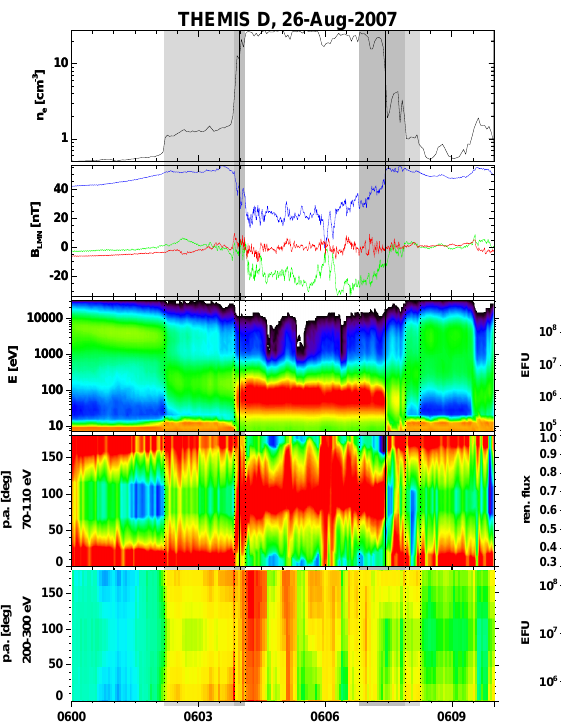
Fig. 7. Event 1. The electron density; the magnetic field in the LMN coordinate system (L – red; M – blue; N – green and magni- tude – black); electron energy spectra; the normalized pitch-angle distribution of 70–110eV electrons; and the pitch-angle distribution of 200–300eV electrons from the PEER (reduced electron spectra from 6 angles) regime at 06:00–06:10UT. The dark and slight grey areas denote the outer and inner LLBL, respectively, and the black lines show crossings of the current sheet.